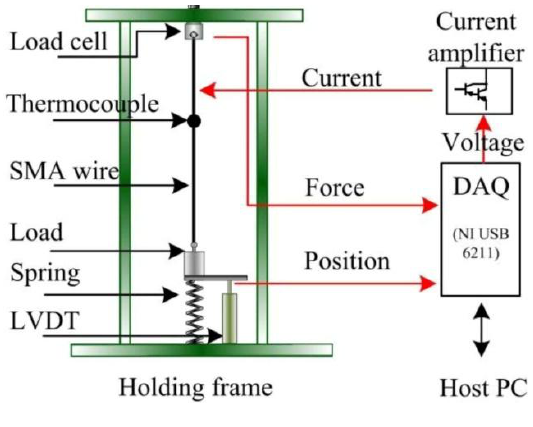
Figure 4. Schematic diagram of the experimental